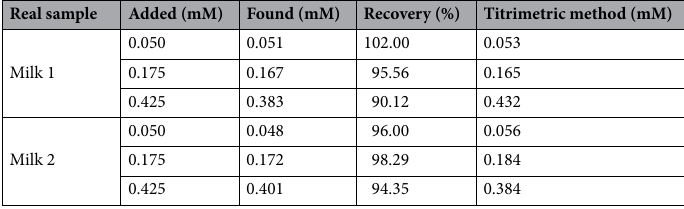
Table 3. Actual sample analysis of CuxO/Ag@FLG/GCE in milk (n = 3).